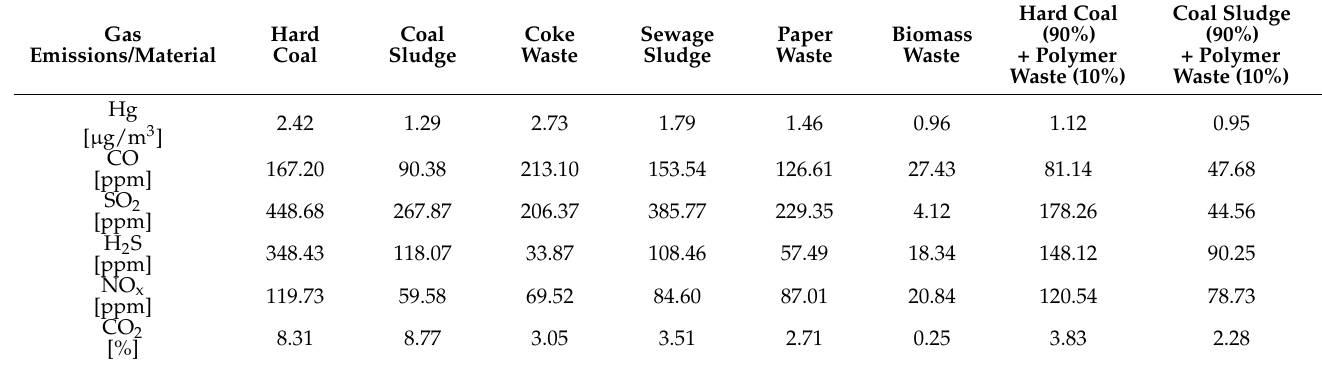
Table 5. The average value of emission of pollutants for the analysed